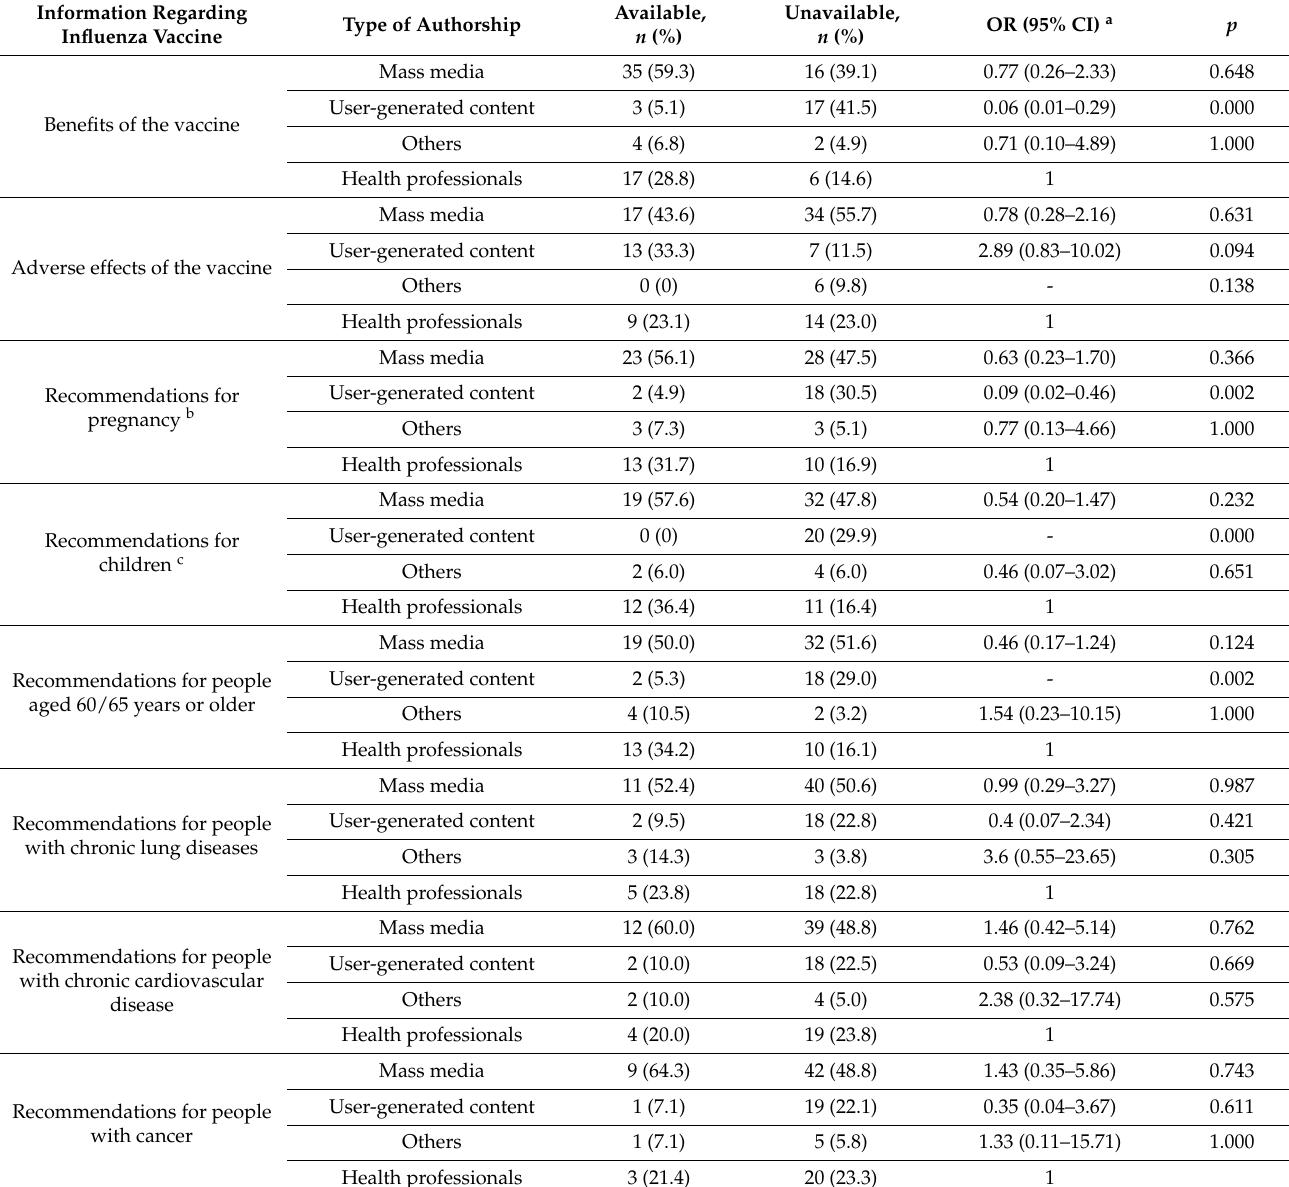
Table 6. Type of authorship and information discussed regarding the influenza